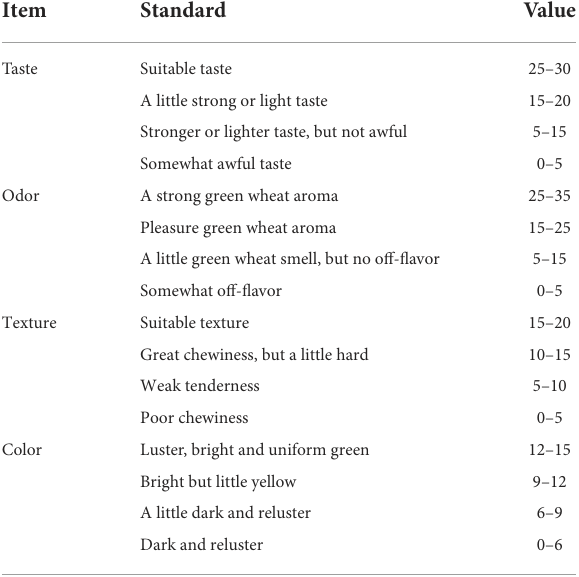
TABLE 2 Standard and value of sensory